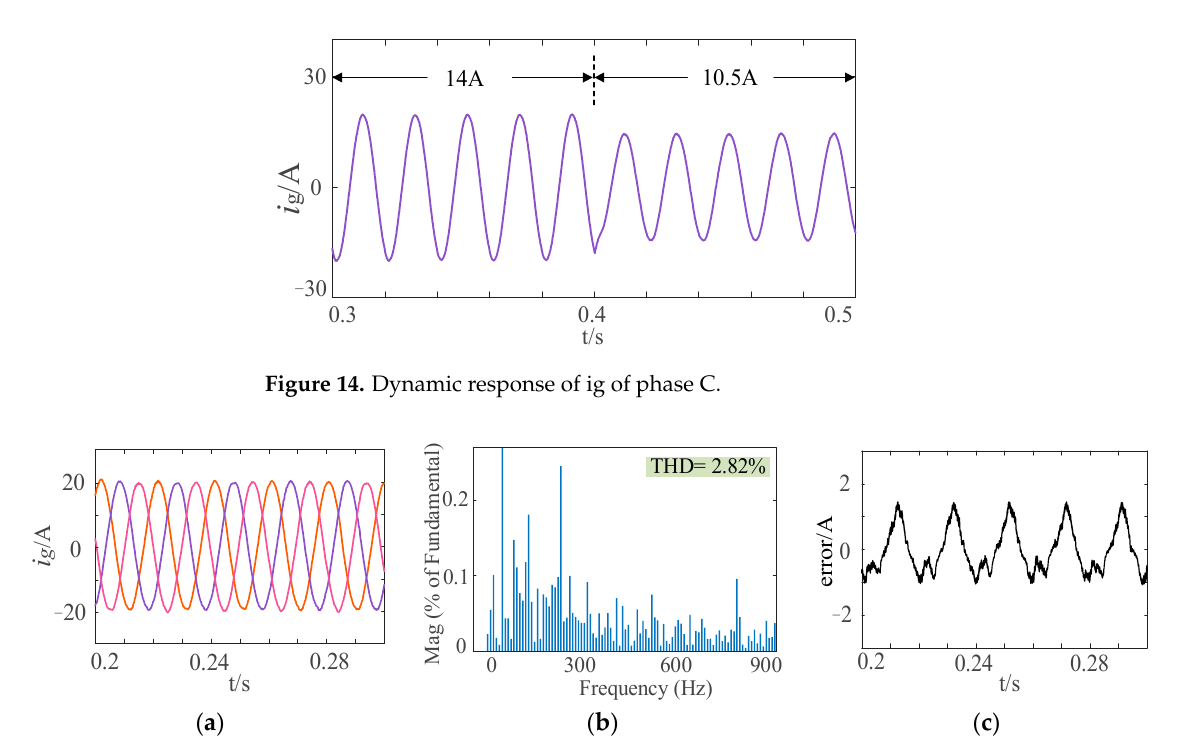
Figure 15. Simulation results of CPRRC at 50.8 Hz: ( a ) Grid current i g . ( b ) Harmonic spectrum of i g_c . ( c ) Current tracking error ε .